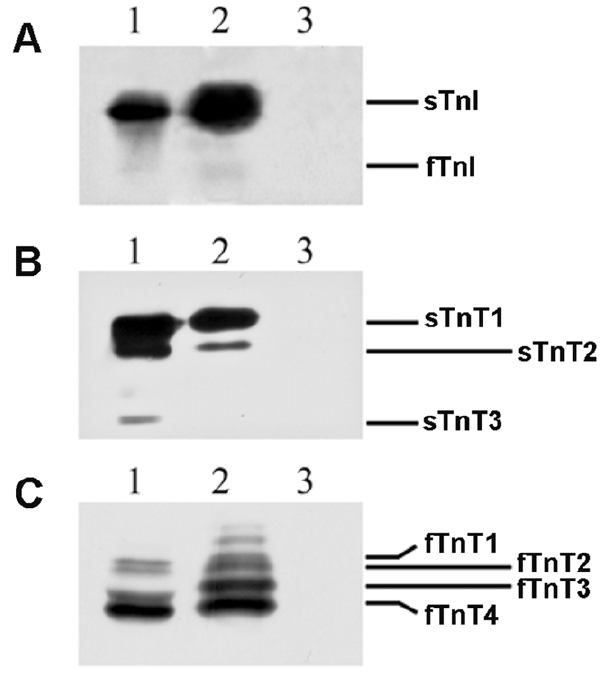
Figure 4. Characterization of O-GlcNAcylation on regulatory proteins of thin filament. O-GlcNAc contractile proteins extracted from soleus were enriched using RL-2 immunoprecipitation protocol. The separation of immunoprecipitated proteins on 10–20% SDS-PAGE was followed by a western blot analysis using antibodies directed against troponin I (A), and slow and fast troponin T (respectively B and C); each isoform was indicated close to the blot. Lane 1 corresponds to whole contractile protein extract from soleus muscle (25 m g of contractile proteins); lane 2 to RL-2 immunoprecipitation protocol; lane 3 to immunoprecipitation experiment performed on hexosaminidase- treated proteins, i.e . on deglycosylated contractile proteins. Only the region of the protein of interest is